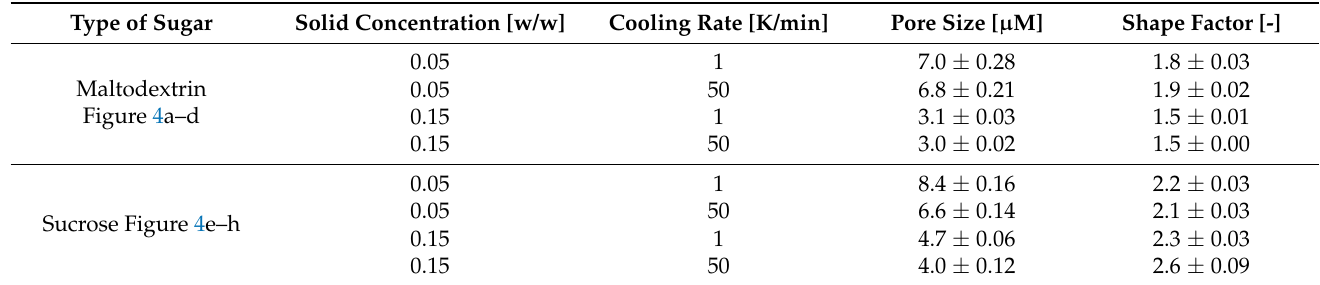
Table 3. Overview of the structural parameters of different microstructures. Arithmetic mean values with confidence interval with 0.95 confidence